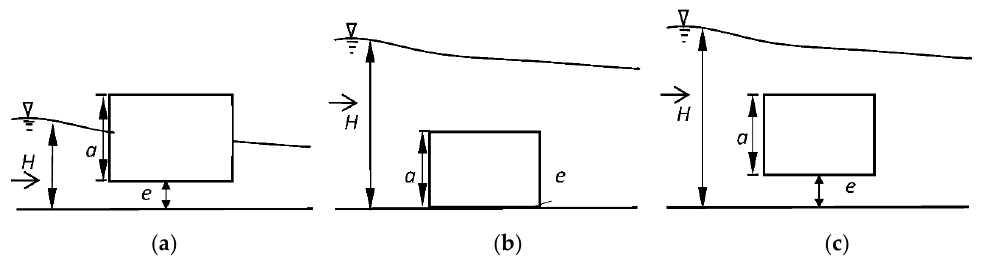
Figure 2. The sketches of different flow states: ( a ) orifice flow; ( b ) weir flow; ( c ) combined orifice-weir flow.